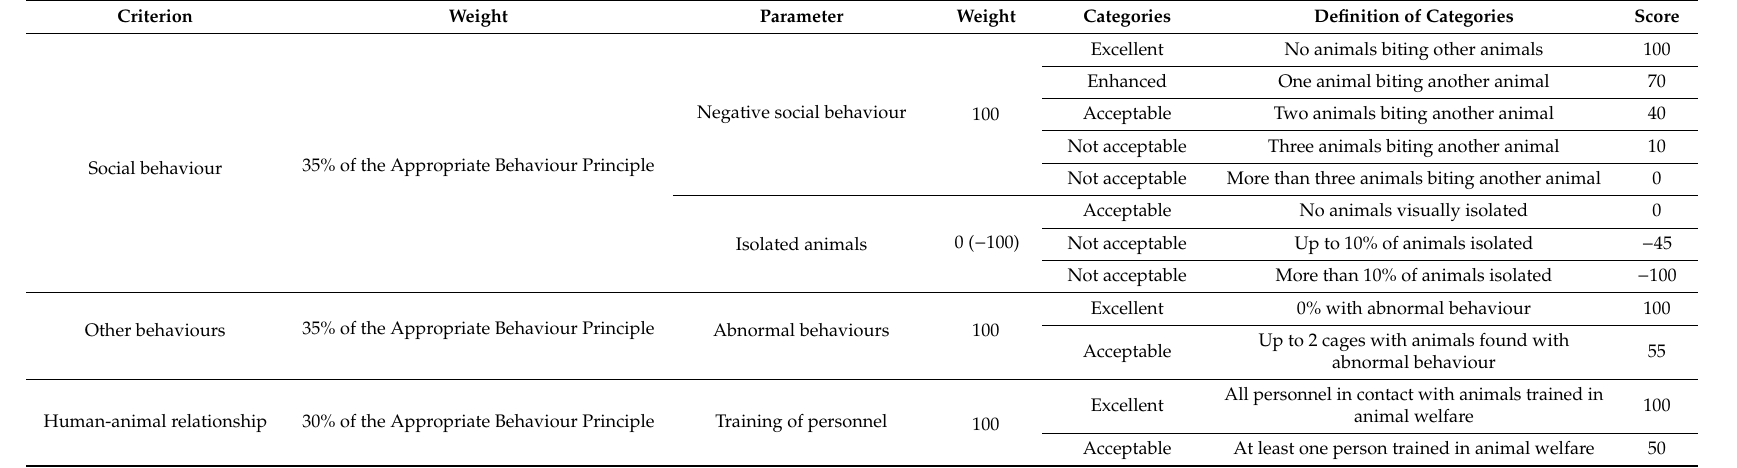
Table 5. Parameters used to assess the social behaviour, other behaviours and human–animal relationship criteria within the Appropriate Behaviour Principle. Each criterion is assessed by a single measure, except social behaviour. In this case, if no animals isolated are found the score is not altered, but if any are found then some points can be subtracted from the whole criterion. In some cases, the category Not acceptable can have more than one